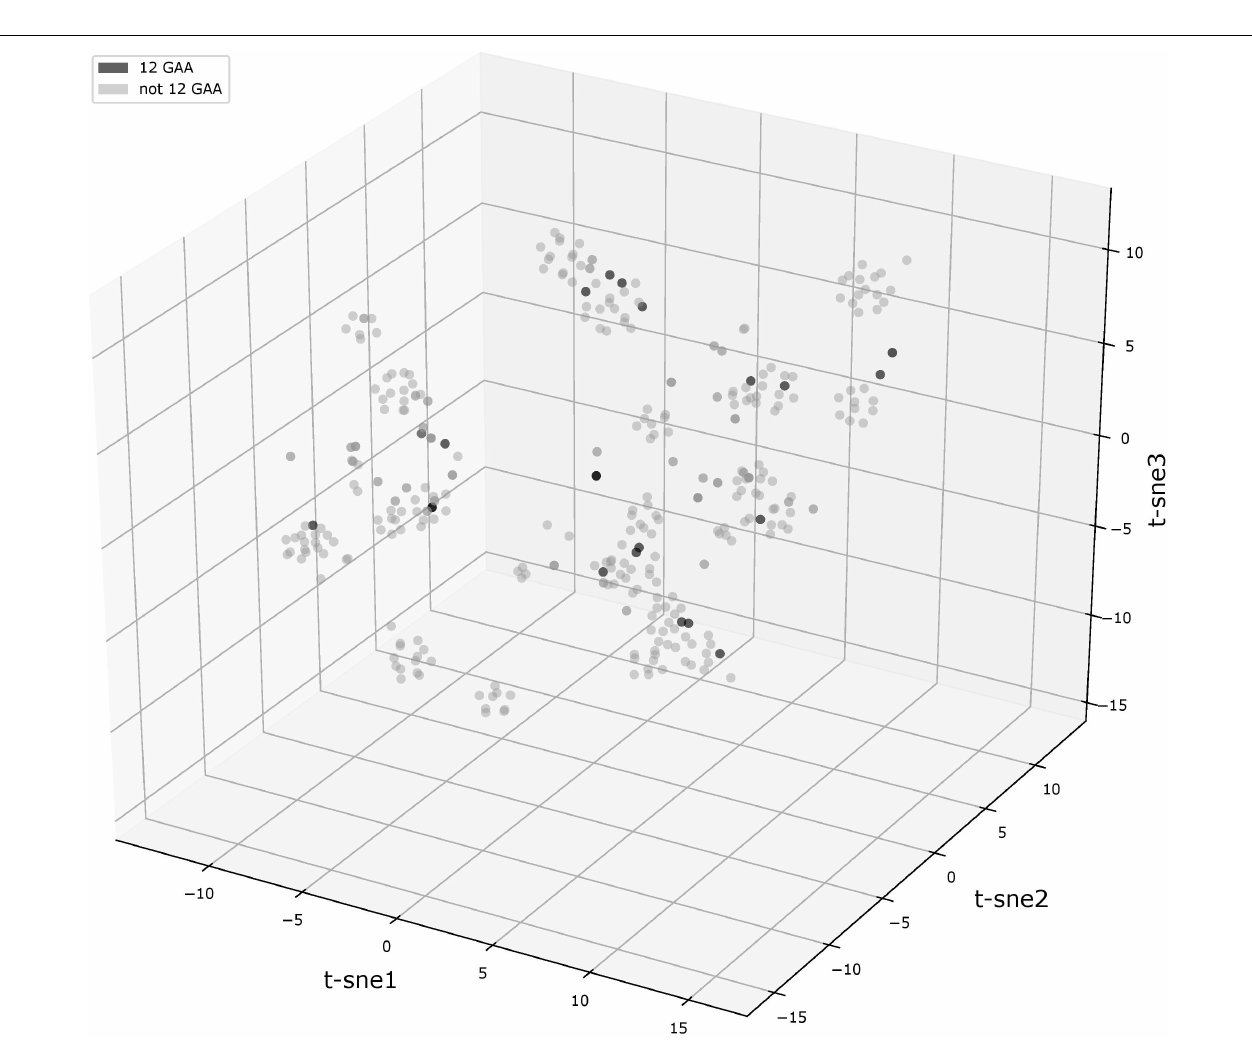
FIGURE 2 | t-SNE analysis plot of (GAA)n flanking motifs. Points represent individual vlhA genes of all analyzed strains, the analysis made on concatenated left and right (GAA)n flanking sequences. Black points show 12-GAA promoters. In analysis was used t-SNE algorithm implemented in sklearn Python library with the parameter of perplexity